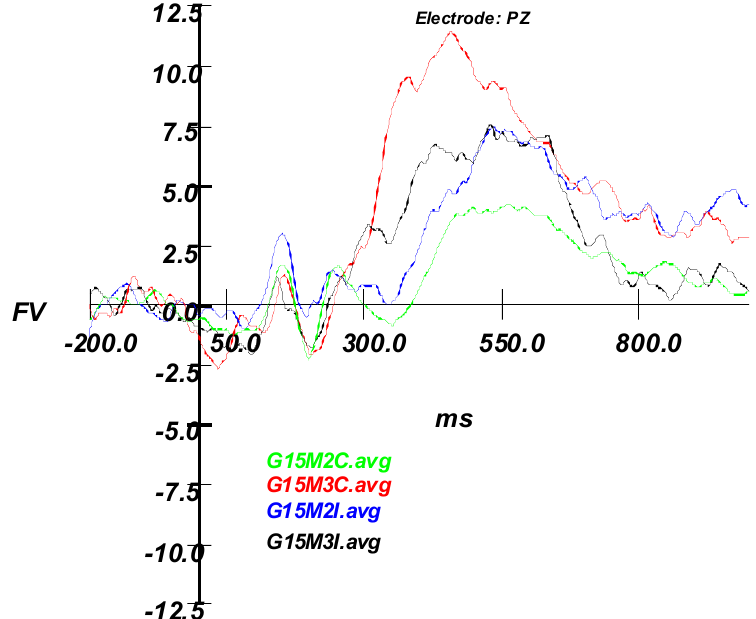
Figure 6. Experiment 2 grand average waveforms for all Simulating conditions. Note how the incorrect Match condition results in a smaller P3 response than the correct Match condition. G15M2C = Grand Average Simulating Mismatch Correct; G15M3C = Grand Average Simulating Match Correct; G15M2I = Grand Average Simulating Mismatch Incorrect; G15M3I = Grand Average Simulating Match Incorrect.